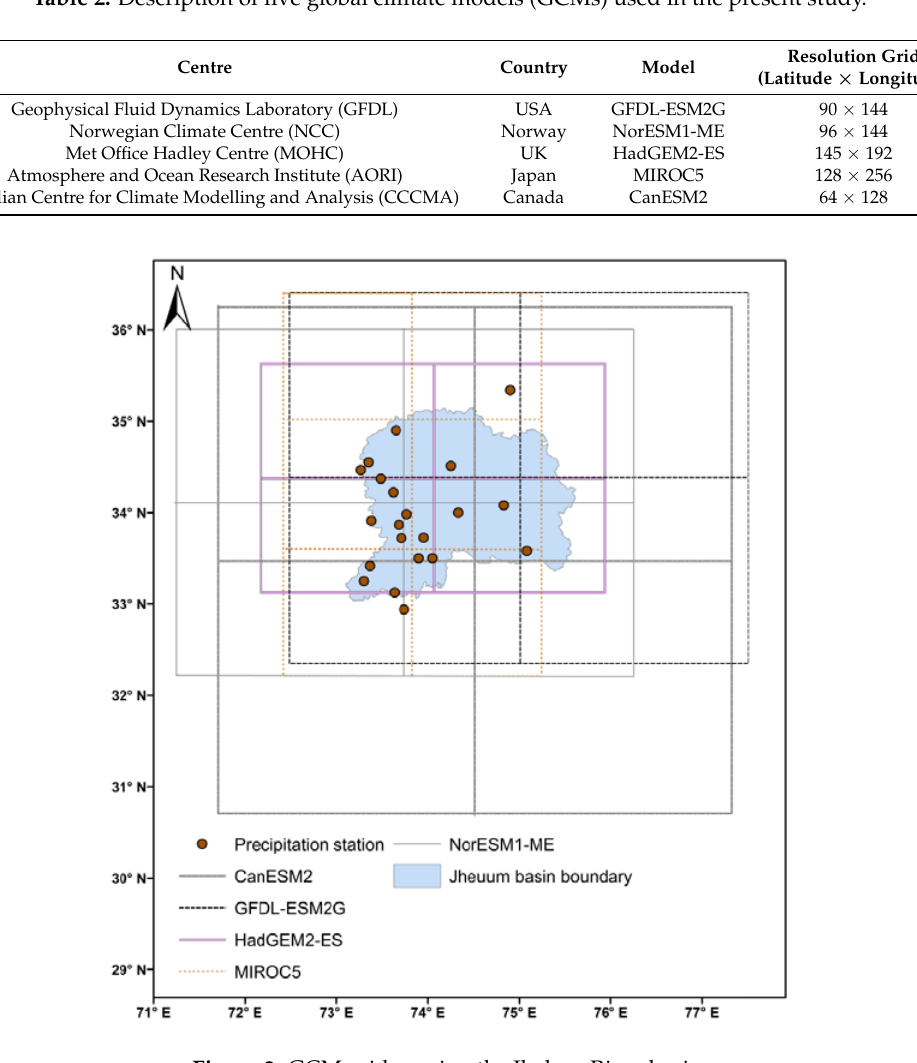
Table 2. Description of five global climate models (GCMs) used in the present study.